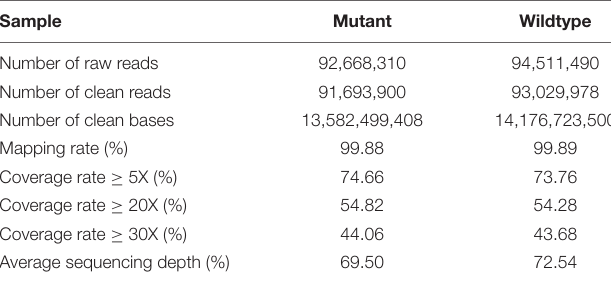
TABLE 3 | Statistics of exome-capturing sequencing and mapping